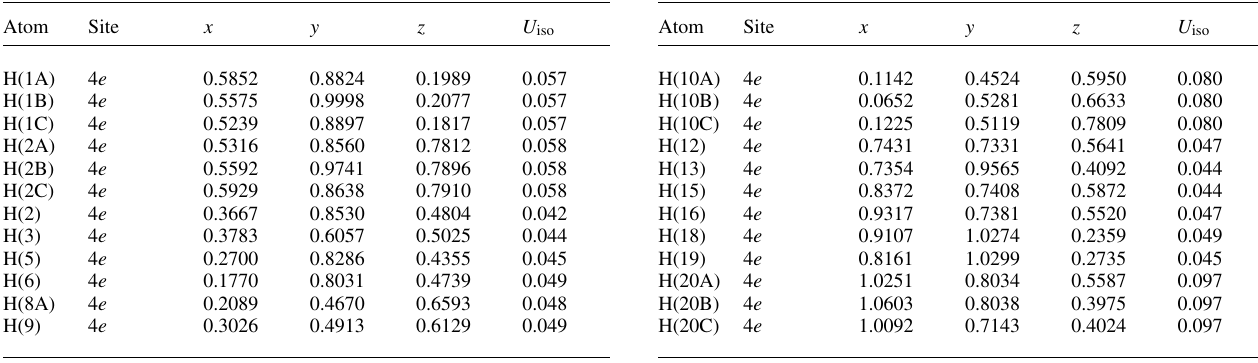
Table 2. Atomic coordinates and displacement parameters (in Å 2 )